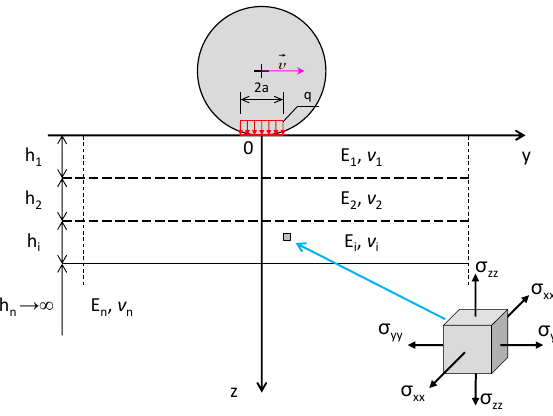
Figure 6. Model of the flexible asphalt pavement structure used for analysis.